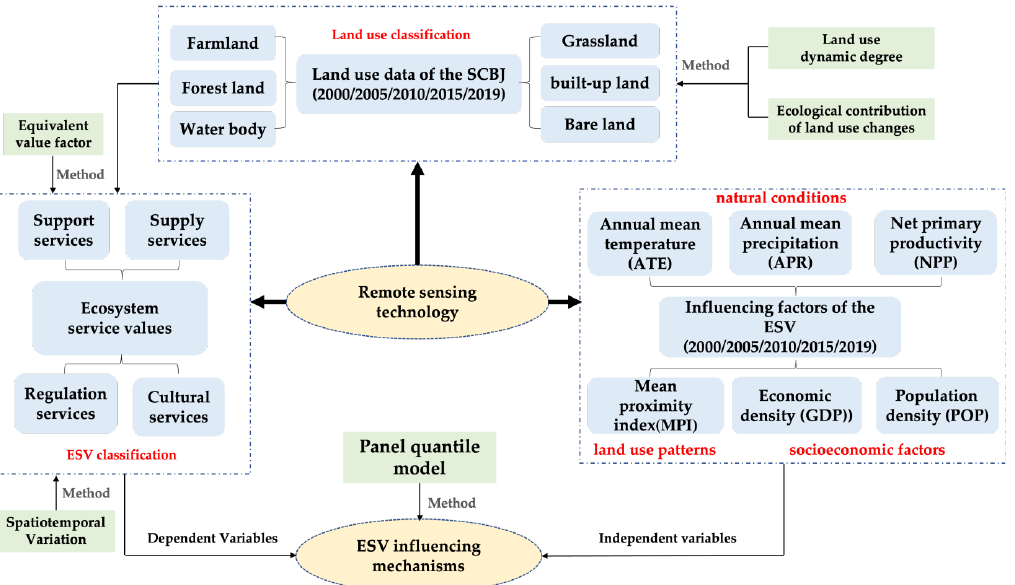
Figure 2. Flow chart of research based on remote sensing technology.